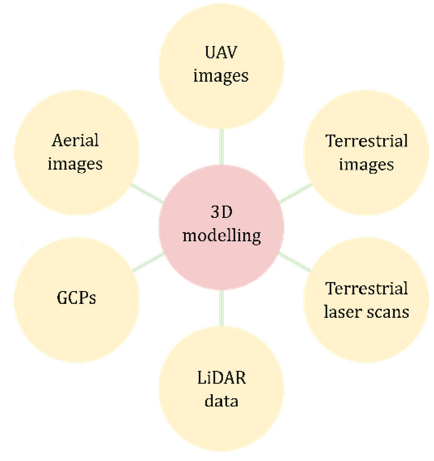
Figure 2. Spatial data collection